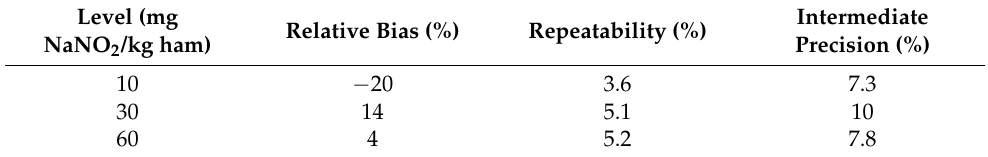
Table 2. Trueness and precision (relative standard deviation, RSD %) ( k = 3, n = 3, p = 3) studies. Level